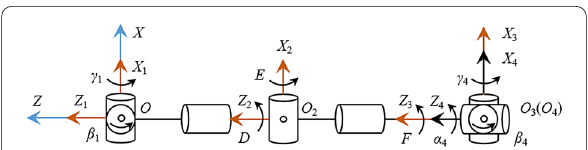
Figure 9 Mechanism diagram of the equivalent series robotic